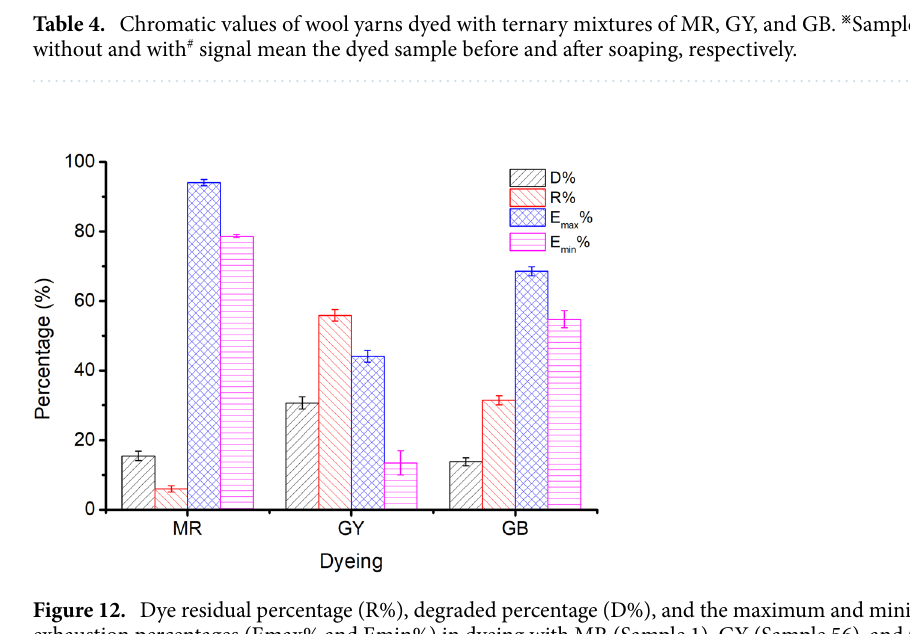
Figure 12. Dye residual percentage (R%), degraded percentage (D%), and the maximum and minimum dye exhaustion percentages (Emax% and Emin%) in dyeing with MR (Sample 1), GY (Sample 56), and GB (Sample